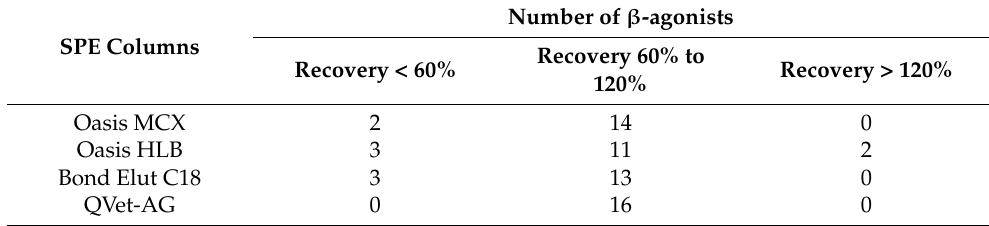
Table 4. Effect of SPE column on the recovery of sixteen β -agonists.